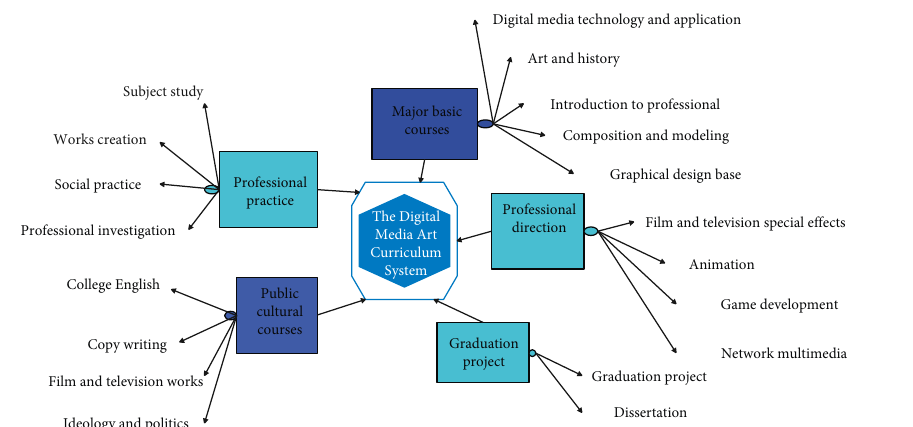
Figure 2: Internet and digital media topology diagram.